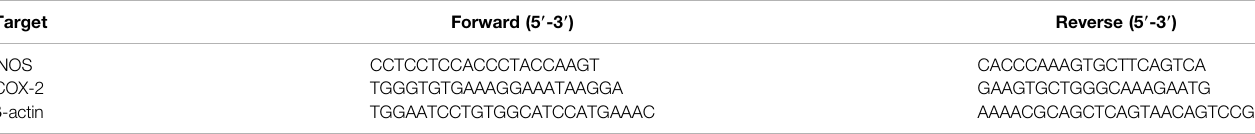
TABLE1 | The primer sequences of iNOS and